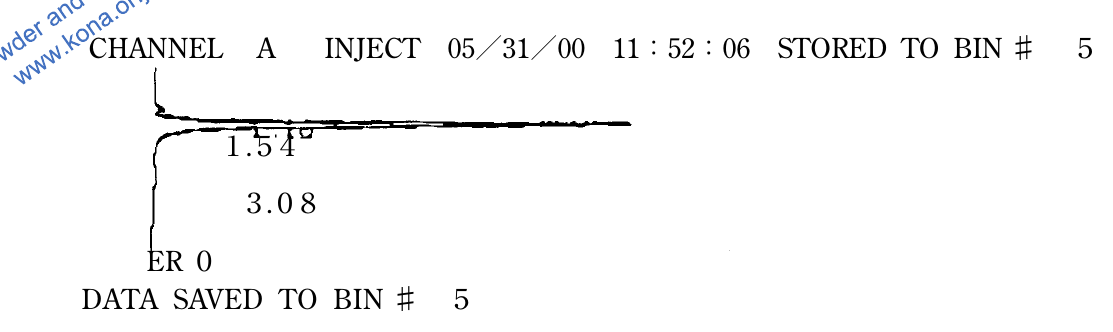
Fig. 2 Insulin Isolation for in vitro Drug Release System.